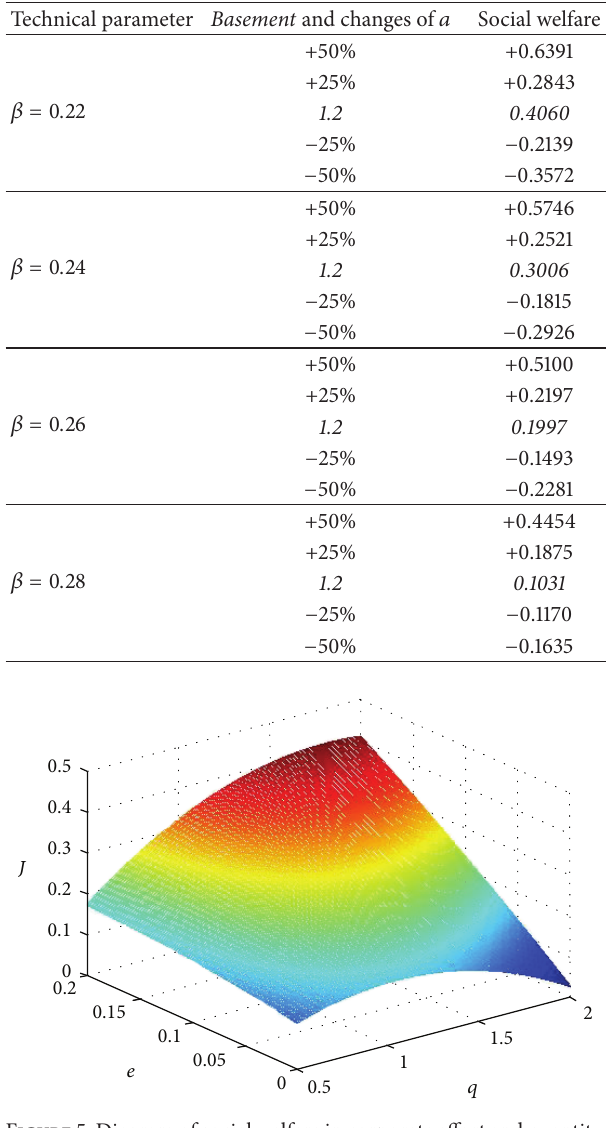
Table 1: Sensitivity analyses for social welfare versus 𝑎 .